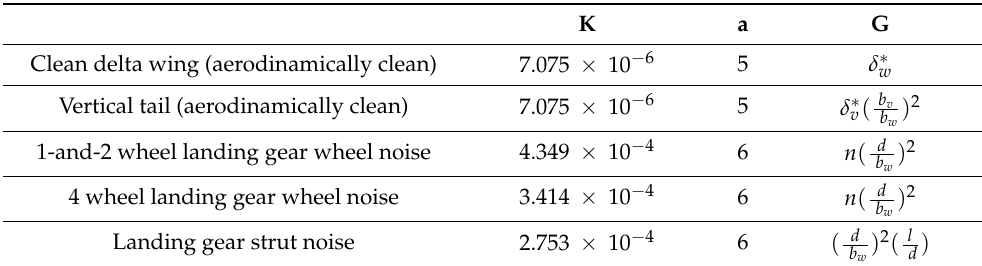
Table 2. K , a and G for each airframe noise source [24].